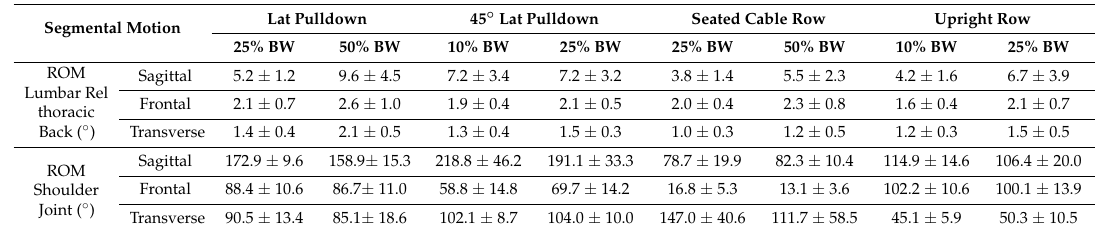
Table A2. Mean and maximum values over all subjects for the curvature in the thoracic and lumbar regions.